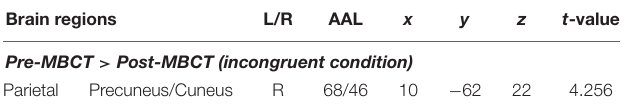
TABLE 5 | Peak locations of brain regions showing intervention differences in brain activity during incongruent condition of numerical Stroop task (AlphaSim corrected p <